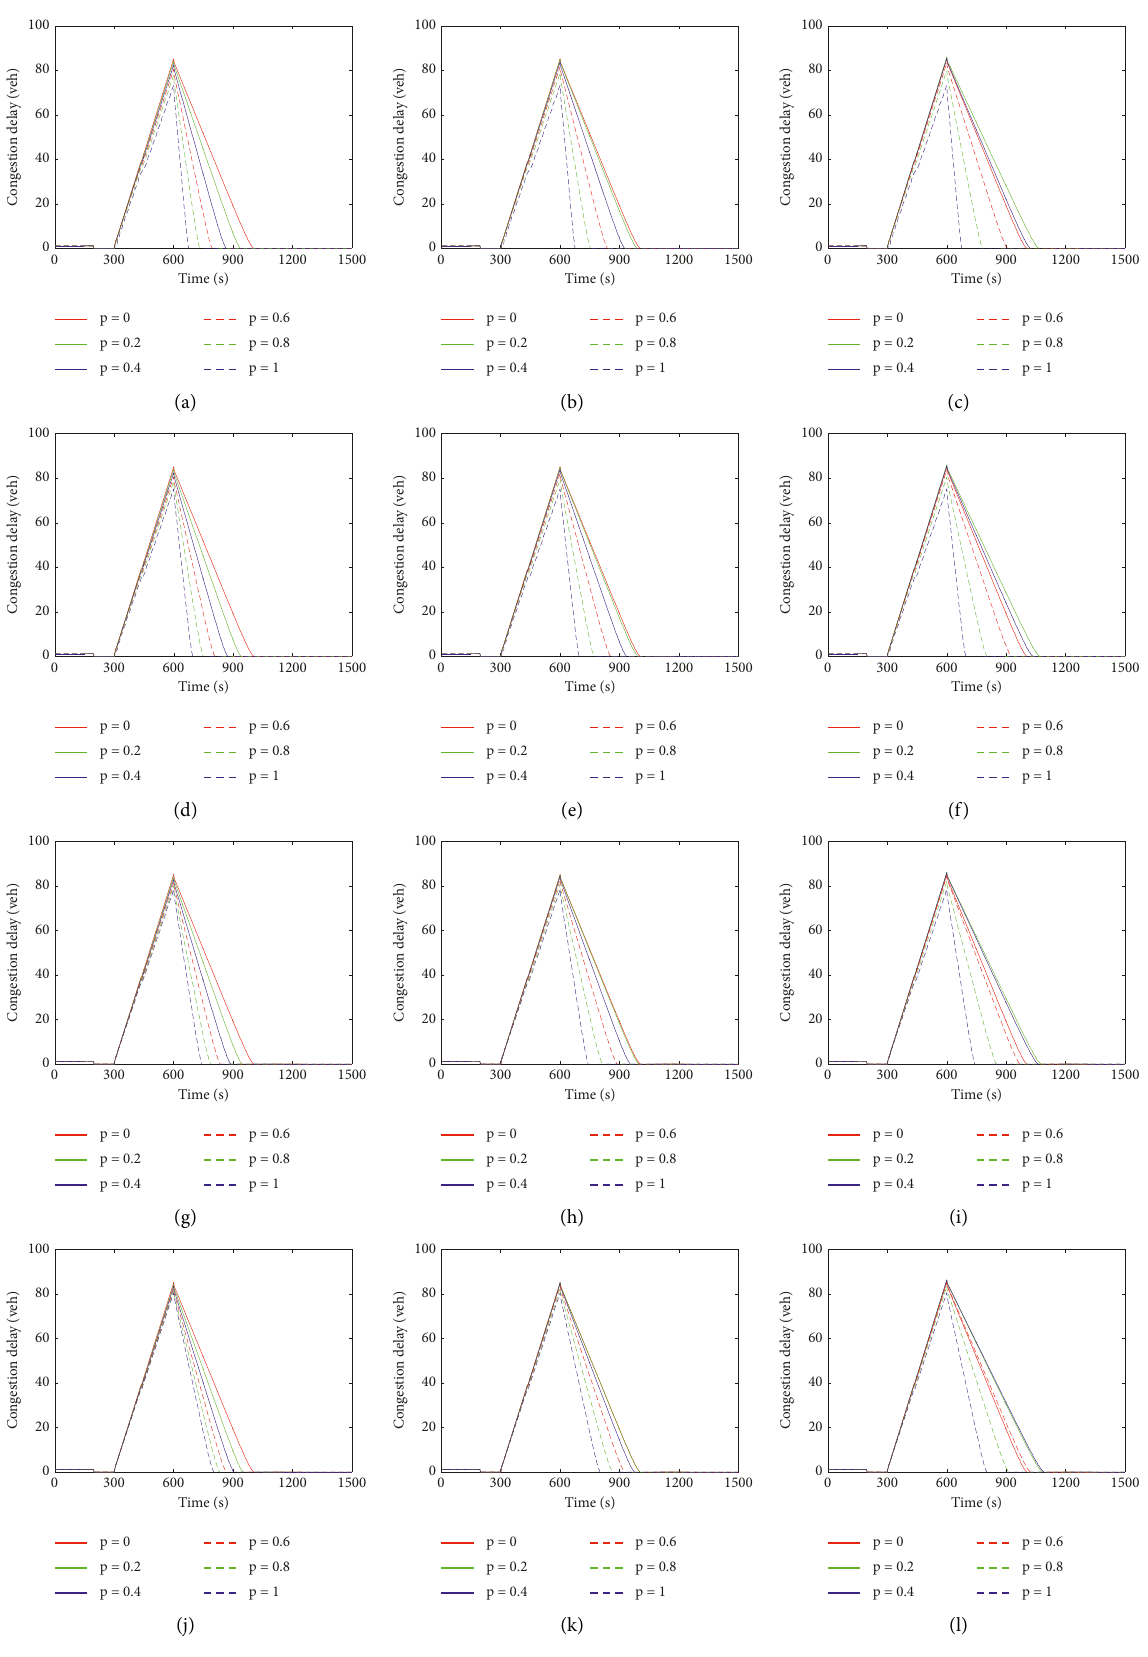
Figure 12: Traffic congestion delay under different model parameters: (a) t (d) t A � 1 . 1 ,t C � 0 . 7, (e) t A � 1 . 6 ,t C � 0 . 7, (f) t A � 2 . 2 ,t C � 0 . 7, (g) t A � 1 . 1 ,t C � 0 . 9, (h) t A � 1 . 6 ,t C � 0 . 9, (i) t A � 2 . 2 , t C � 0 . 9, (j) t A � 1 . 1 ,t C � 1 . 1, (k) t A � 1 . 6 ,t C � 1 . 1, and (l) t A � 2 . 2 ,t C � 1 .